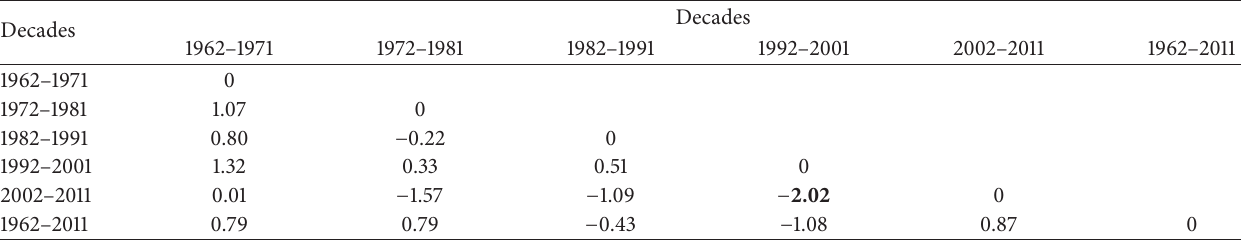
Table 2: Comparisons between the mean annual rainfall of a given decade and the following decades or the entire period by using Student’s 𝑡 -test.